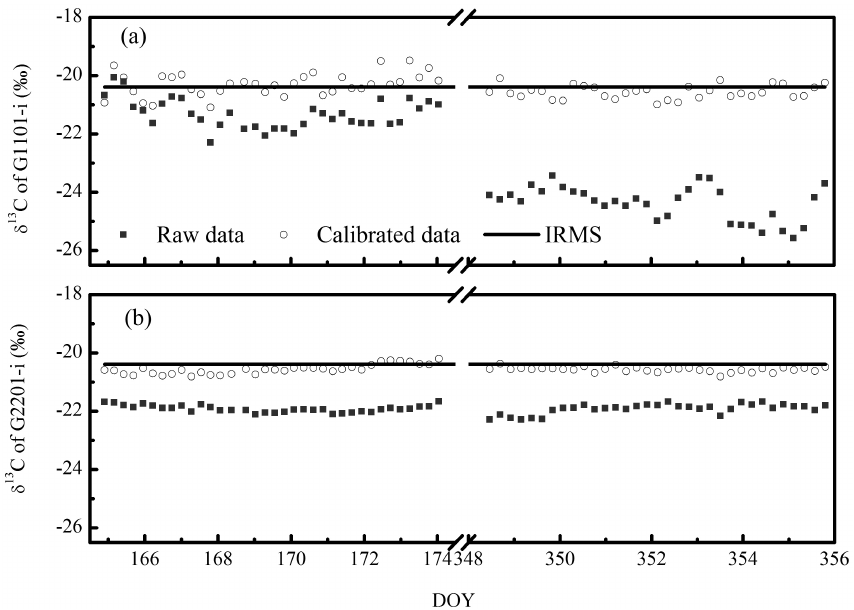
Figure 7. Time series of the 10min averaged δ 13 C of quality control gas (Ref2) monitored by (a) G1101-i analyzer and (b) G2201-i analyzer.